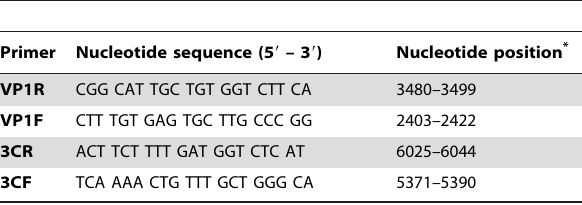
Table 2. Oligonucleotide primer sequences for VP1 and 3C amplification of